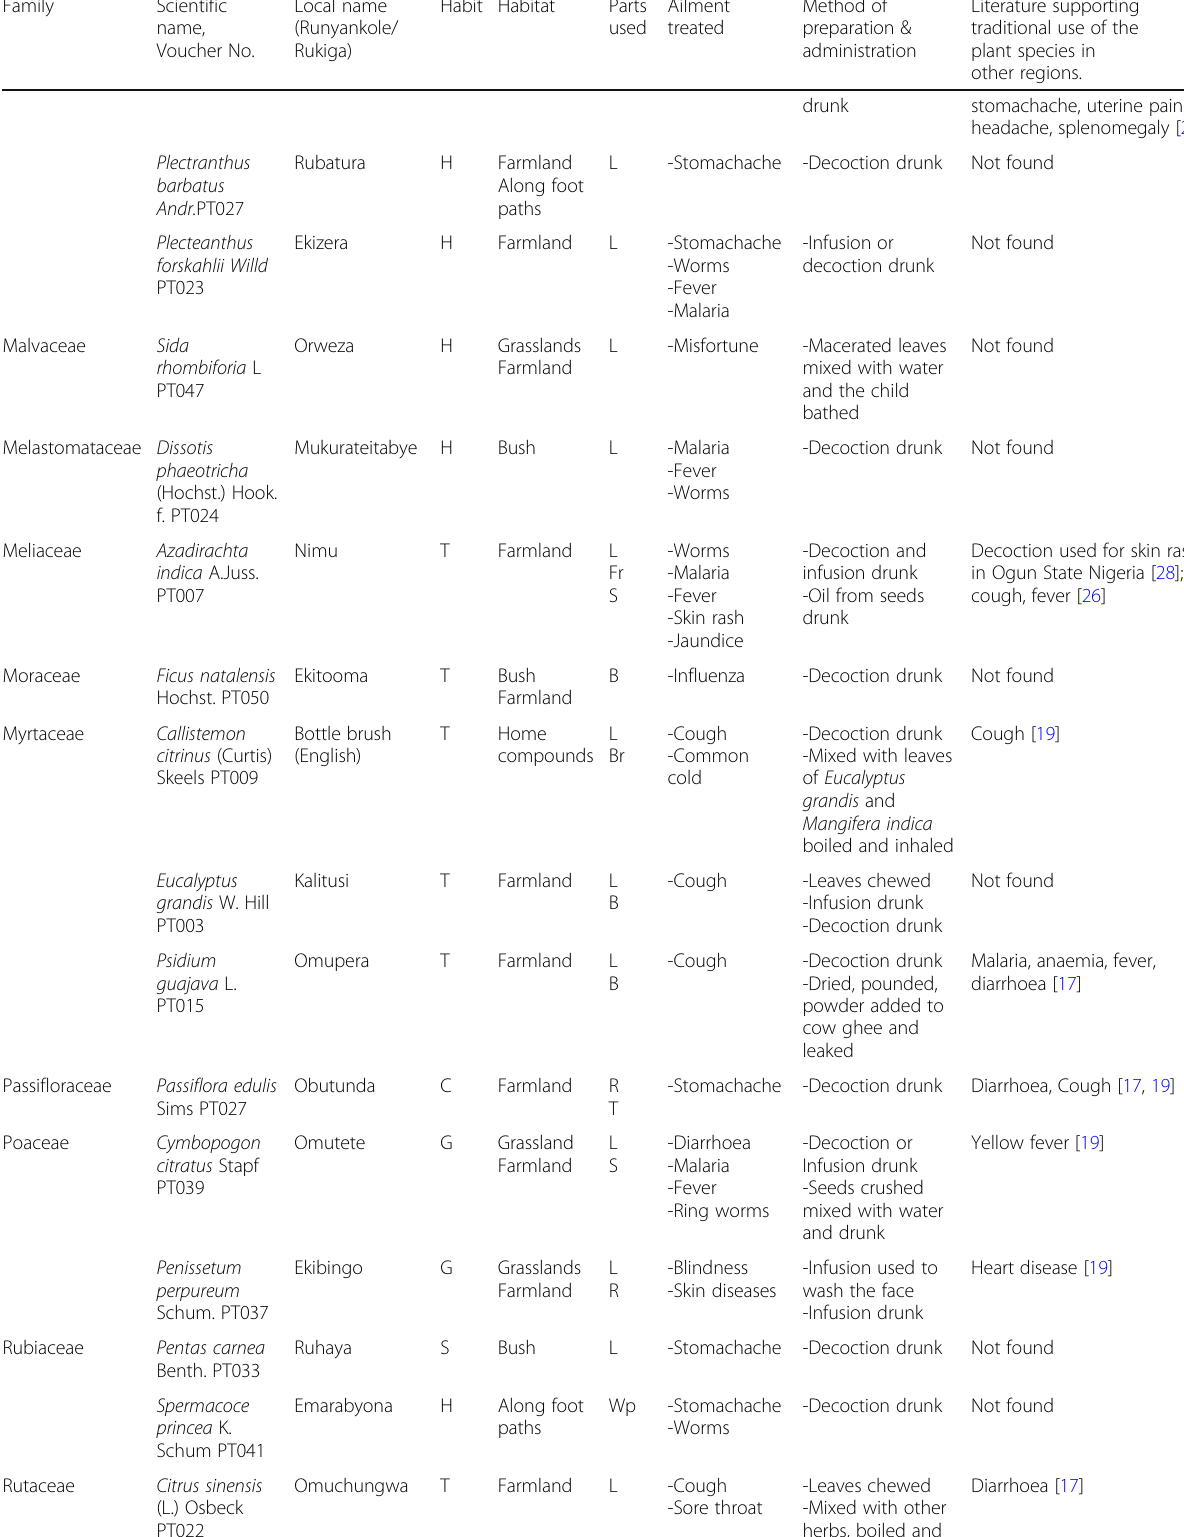
Table 1 Medicinal plant species, their habit, habitat, parts used, ailments treated, mode of preparation and administration